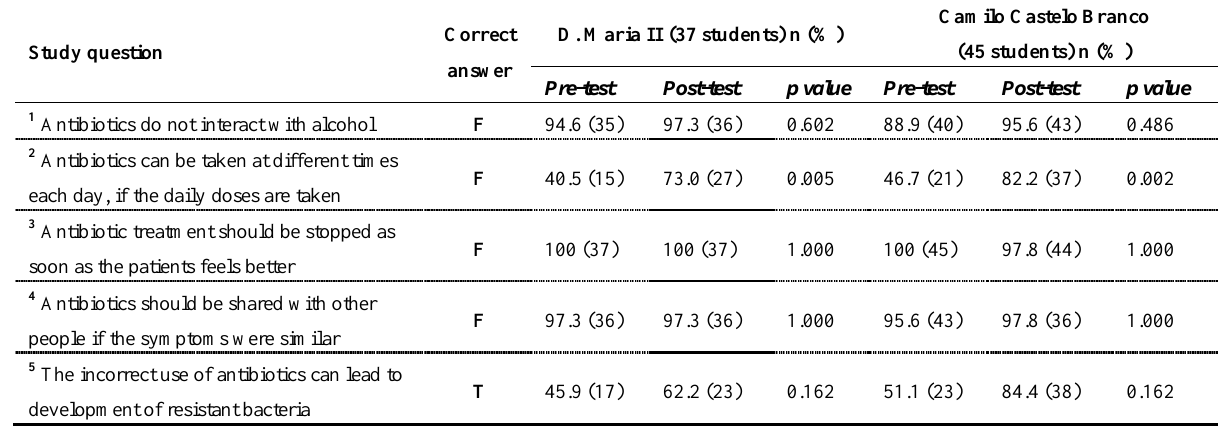
Table 3. Percentage of correct answers to questions on antibiotic treatment for bacterial infections.